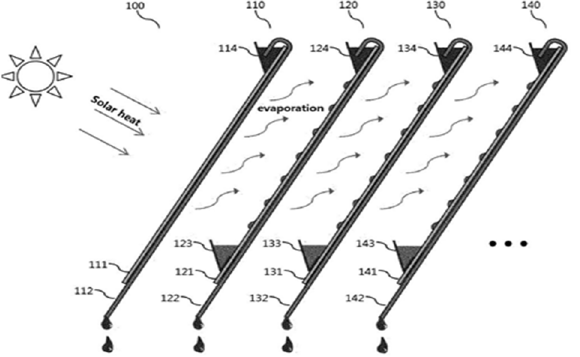
Figure 1. A typical structure of an MSS, with multi-layer condensation channels and an evaporation basin, where product water is collected through the bottom of each channel.